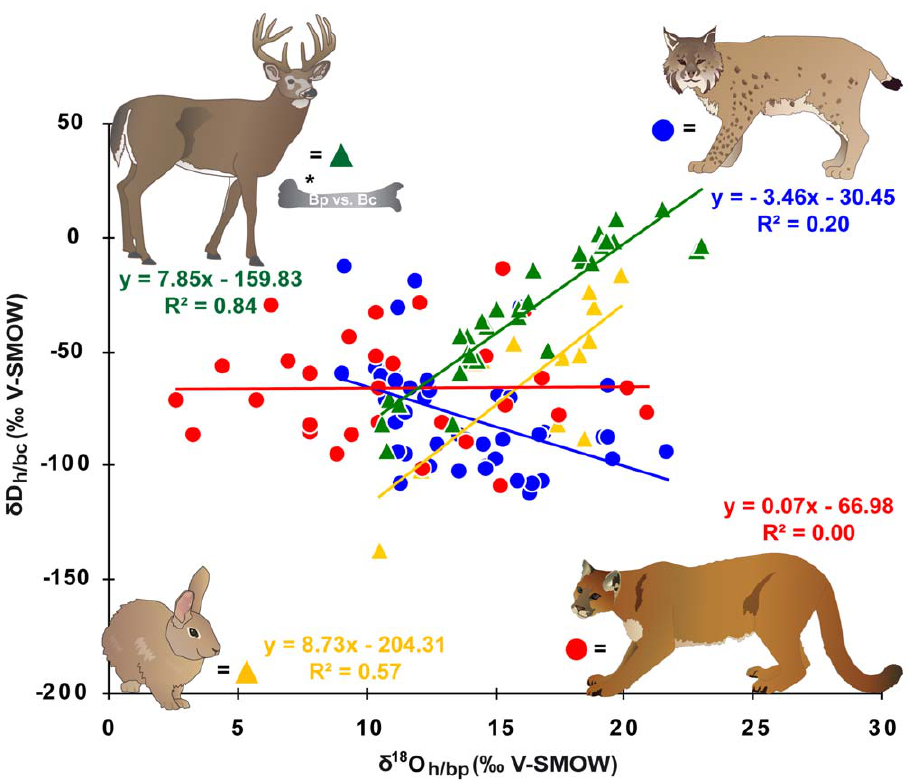
Figure 4. Hydrogen and oxygen isotope ratios of keratin. Hydrogen and oxygen isotope compositions are shown for hair samples ( d D h , d 18 O h ) from puma, bobcat and eastern cottontail rabbit as well as collagen ( d D bc ) and bone phosphate ( d 18 O bp ) data from white-tailed deer* (*data from